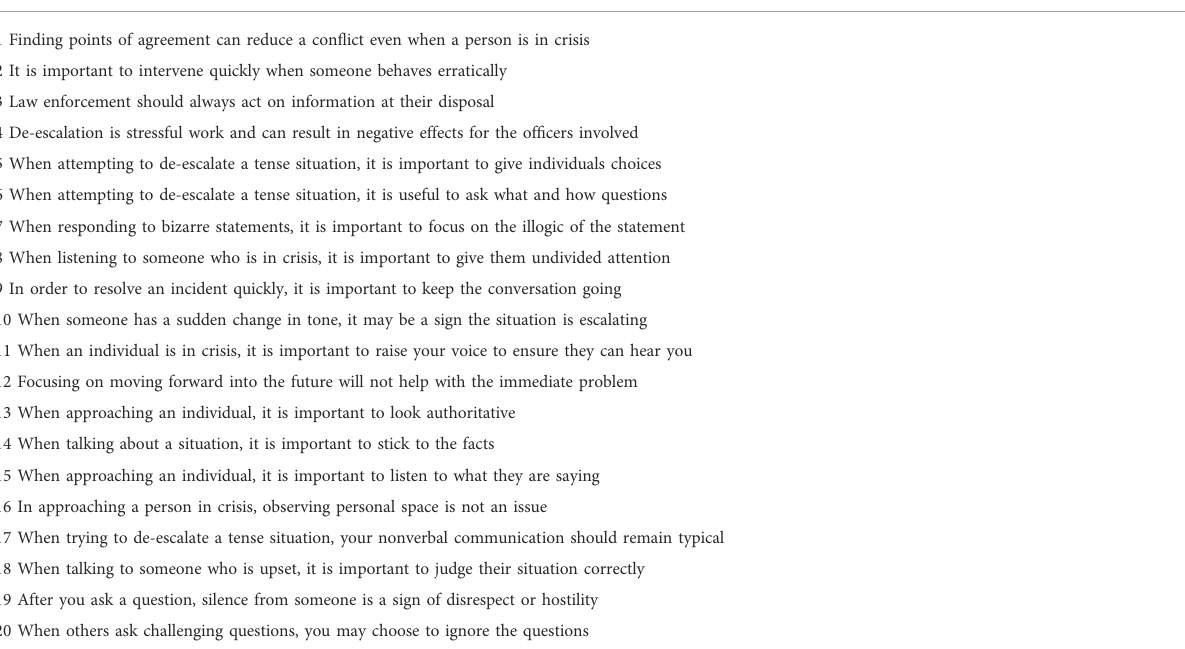
TABLE 4 DE-ESCALATION survey questions † .